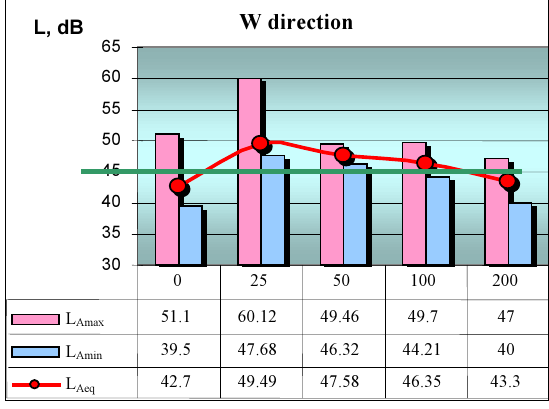
Fig. 5. Wind turbine’s caused noise level dependance on the distance from the noise source (allowed noise level 45